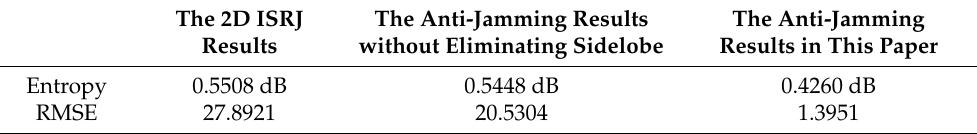
Table 9. Imaging entropies of three different